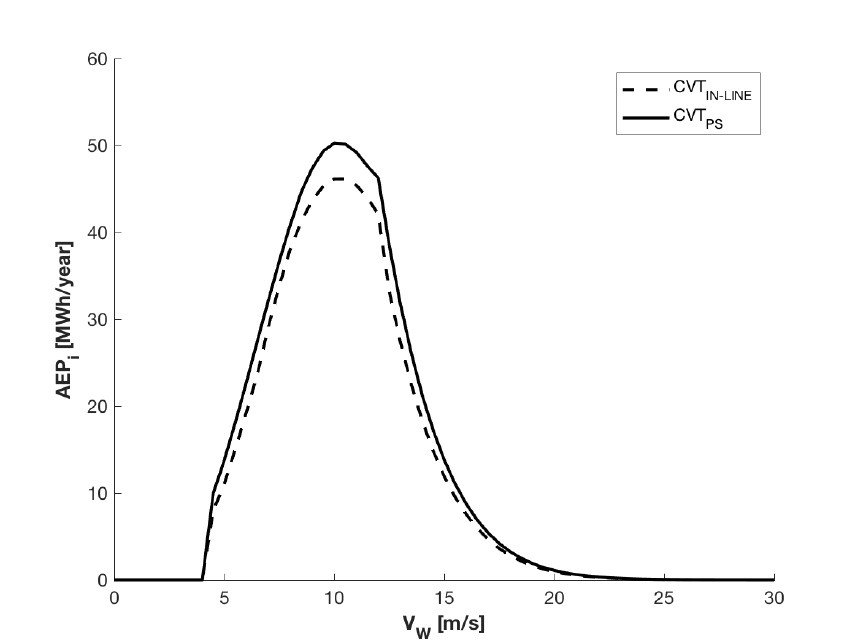
Figure 11. Annual Energy Production (AEP) distribution of the wind turbine for the two architectures for the site characterized by the frequency distribution of wind speed shown in Figure